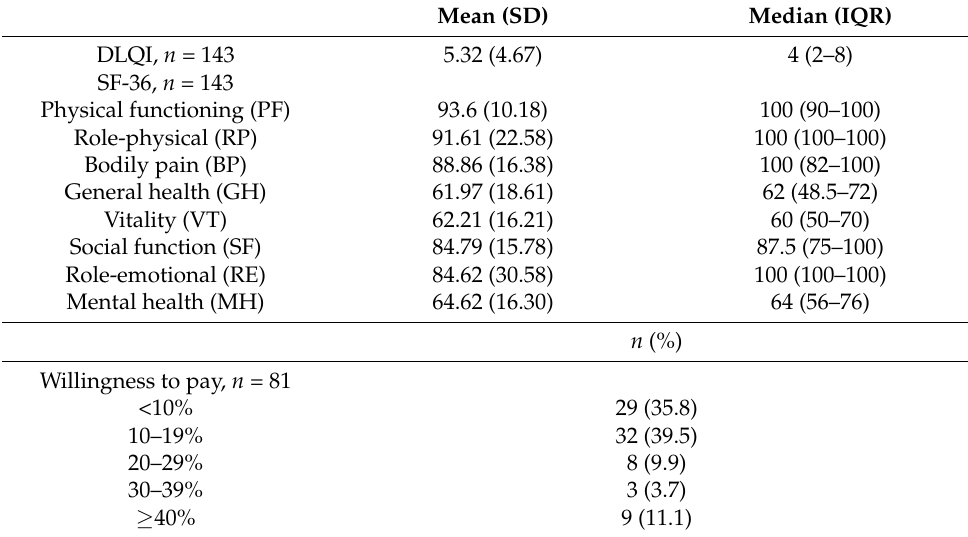
Table 2. Quality of life outcomes.